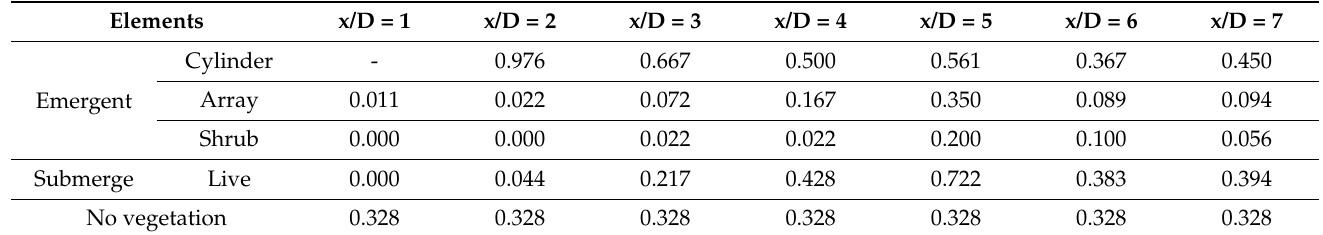
Figure 12. Entrainment rate variation downstream the vegetation elements measured by the He-Ne laser system with the averaged entrainment rate without vegetation. Table 2. Entrainment rate along the normalized distance for different vegetation